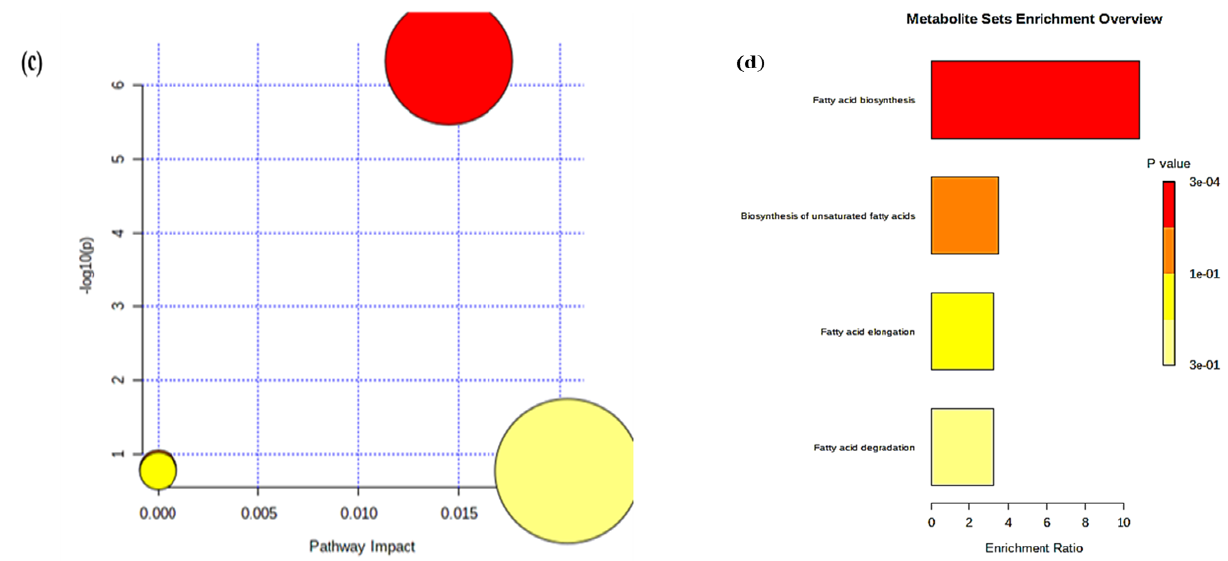
Figure 1 . ( a ) Chromatogram obtained from GC-MS of bovine milk; ( b ) structure of compounds found in bovine milk; ( c ) pathway impact of differential milk metabolites of Holstein Friesian cows with MetaboAnalyst; ( d ) summary plot for over-representation analysis (ORA). Table 2. Results of compound name